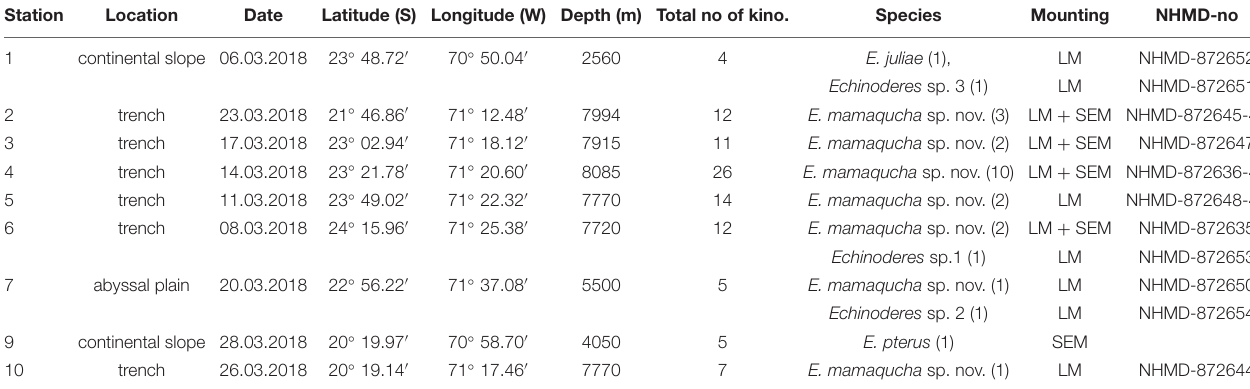
TABLE 1 | Coordinates and basic data of sampling stations and Echinoderes species identities; total no of kino.- total number of processed kinorhynchs (adults and juveniles), species- species identity, together with number of recorded Echinoderes adult specimens, LM-light microscopy, SEM-scanning electron microscopy, NHMD-no – Natural History Museum of Denmark catalog